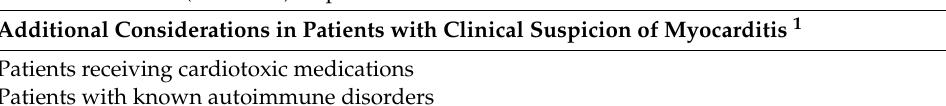
Table 2. Recommended indications for endomyocardial biopsy [1,3]. Main Indications in Patients with Clinical Suspicion of Myocarditis 1 New-onset (2 weeks–3 months) heart failure with hemodynamic compromise, life-threatening ventricular arrhythmias or high-degree atrioventricular block Lack of short term (<2 weeks) response to standard medical treatment Additional Considerations in Patients with Clinical Suspicion of Myocarditis 1 Patients receiving cardiotoxic medications Patients with known autoimmune disorders